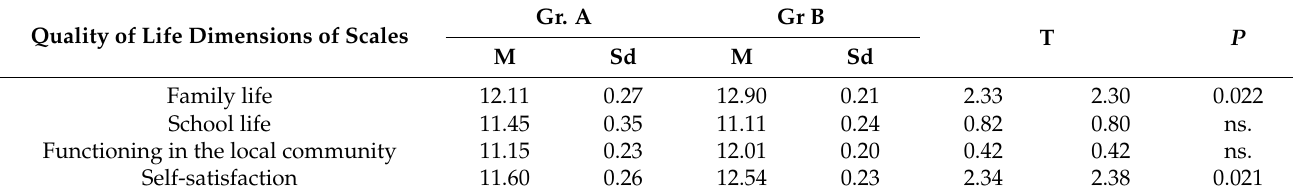
Table 1. Significance of differences between children with ASD from families with low and average financial status in terms of quality-of-life assessment during the SARS-CoV-2 pandemic. Gr. A Gr B Quality of Life Dimensions of Scales T P M Sd M Sd Family life 12.11 0.27 12.90 0.21 2.33 2.30 0.022 School life 11.45 0.35 11.11 0.24 0.82 0.80 ns. Functioning in the local community 11.15 0.23 12.01 0.20 0.42 0.42 ns. Self-satisfaction 11.60 0.26 12.54 0.23 2.34 2.38